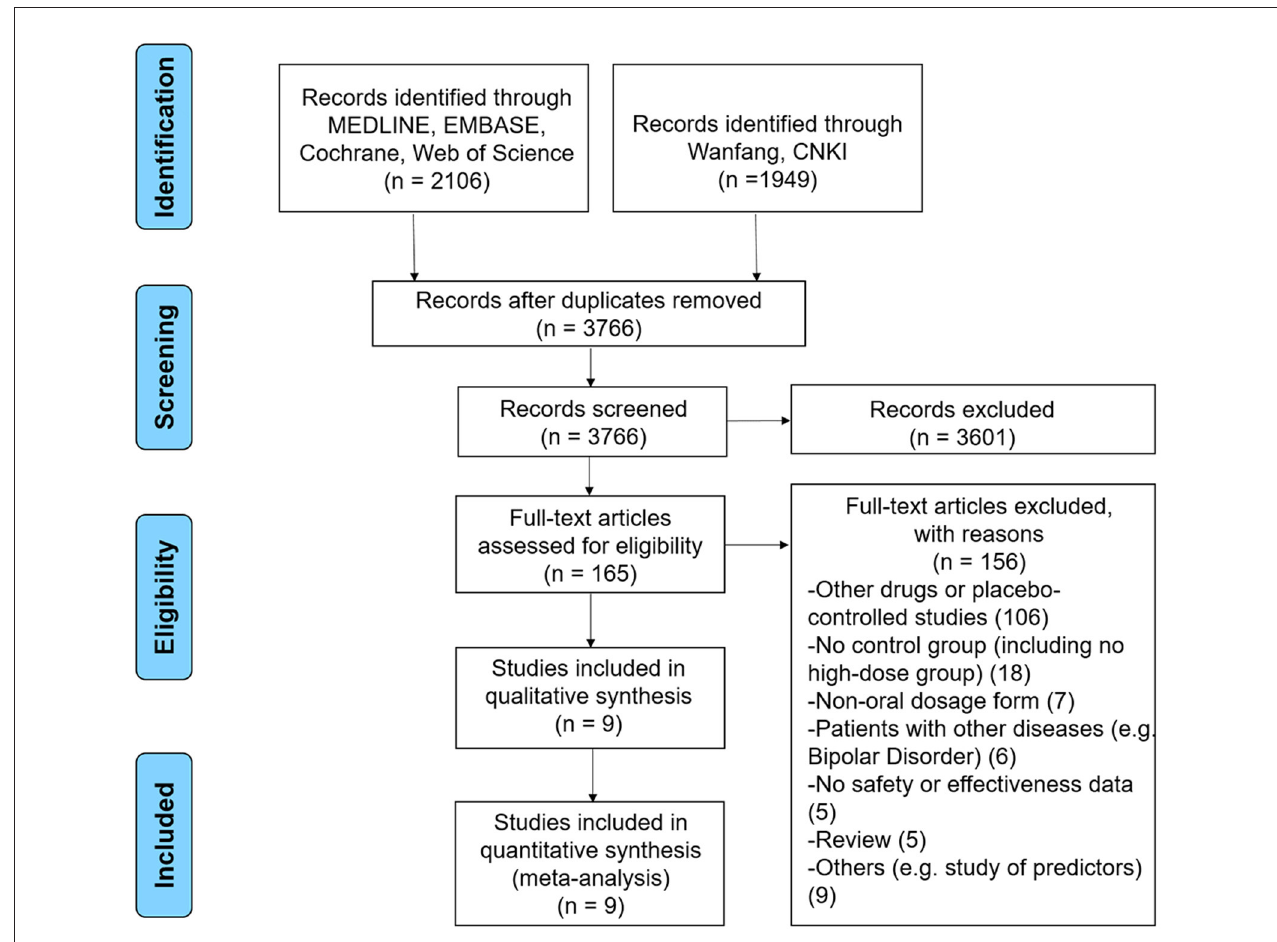
FIGURE 1 | PRISMA flow